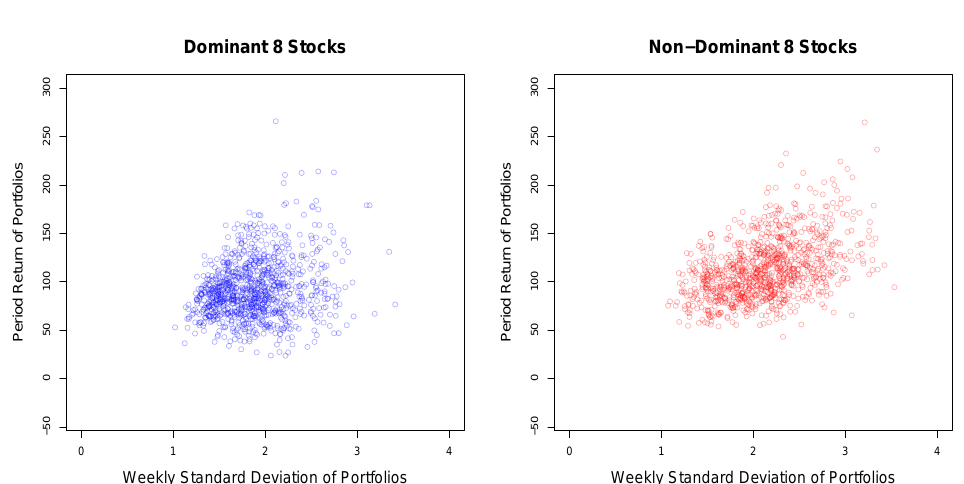
Figure 7. Scatter plots of Period 2 returns against the weekly volatility for the eight-stock portfolios selected on the basis of the clusters identified in neighbor-Nets splits graph from Period 1 with the clusters split into dominant and non-dominant industry